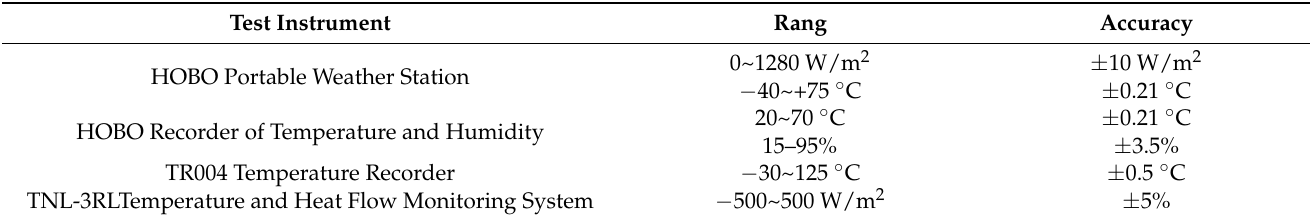
Table 2. Details of measurement